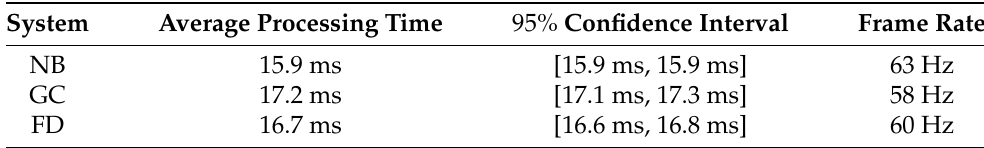
Table 5. Frame rate comparison (conditions: NB—No Blur; GC—Unity Blur;